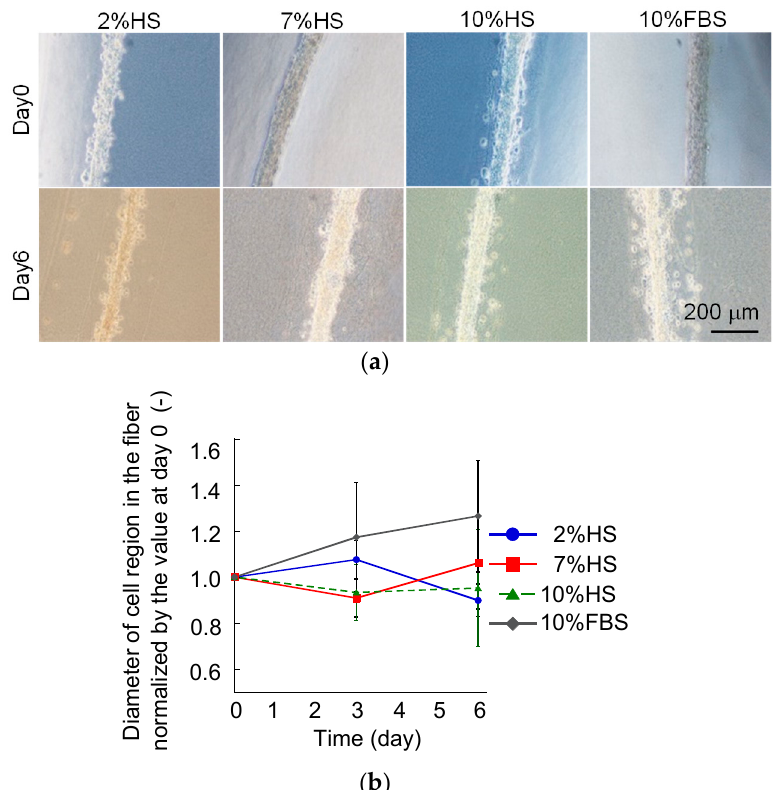
Figure 2. Cell-laden core-shell hydrogel microfiber culture under 2%, 7%, and 10% horse serum (HS) and 10% fetal bovine serum (FBS) conditions. ( a ) Phase-contrast images and ( b ) the change in the diameter of cell-laden core along with culture time. Scale bar: 200 μ m.